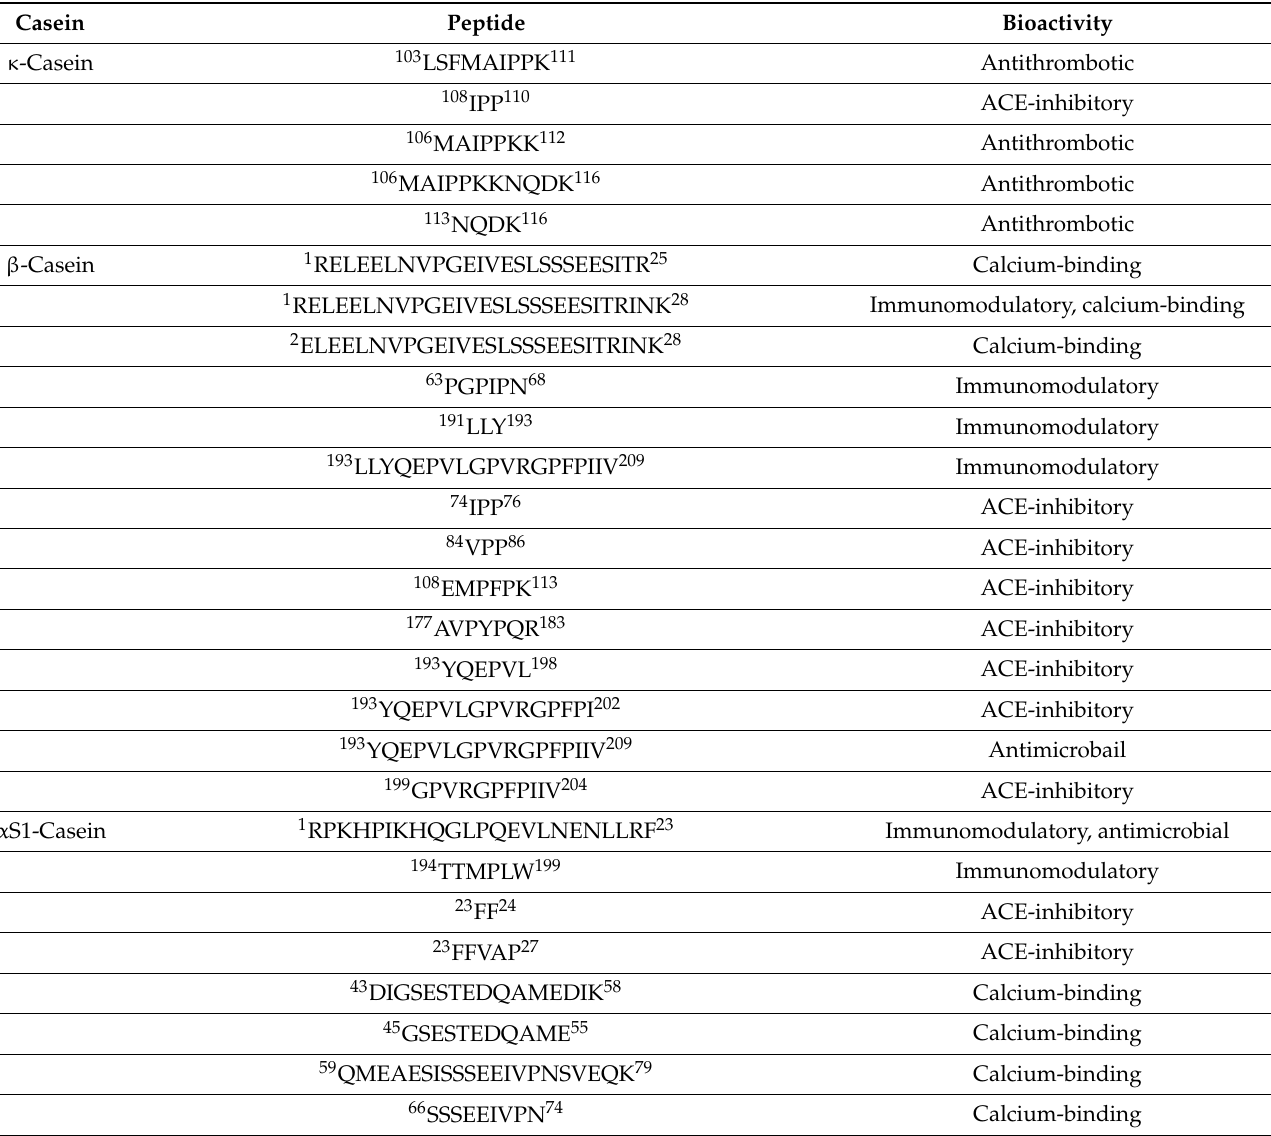
Table 6. Selected bioactive peptides from the proteolysis of cow milk caseins, camel and human (black cow, red camel, and blue human)